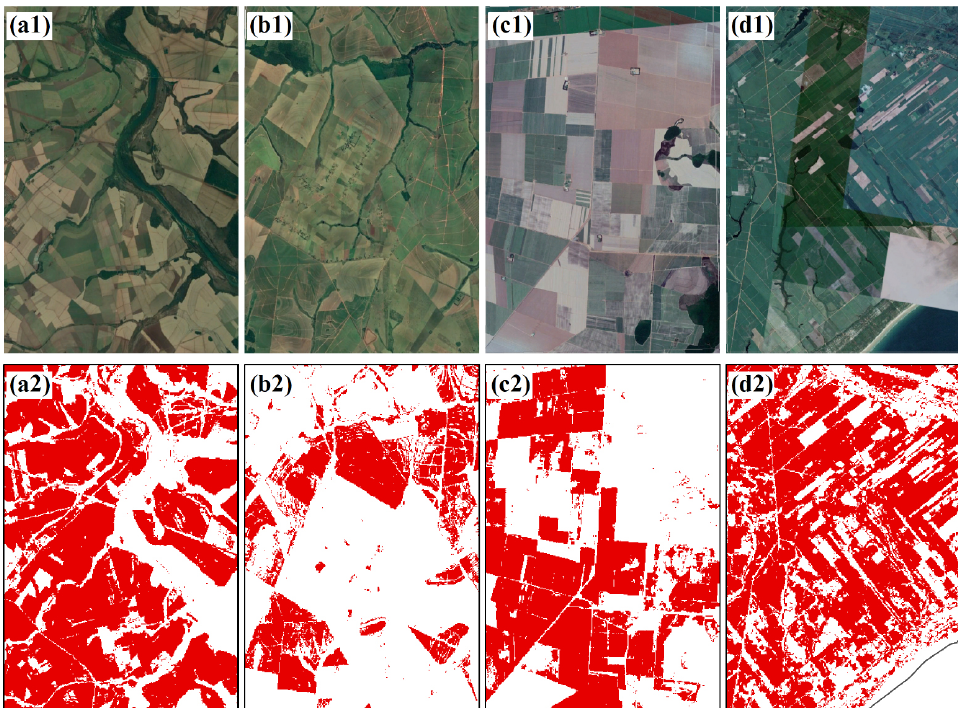
Figure 9. Zoomed-in view of (a1) – (d1) high-resolution images from © Google Earth and (a2) – (d2) presence (red) and absence (white) of sugarcane on the harvest maps in 2018 for the typical area A–D in Fig. 8.